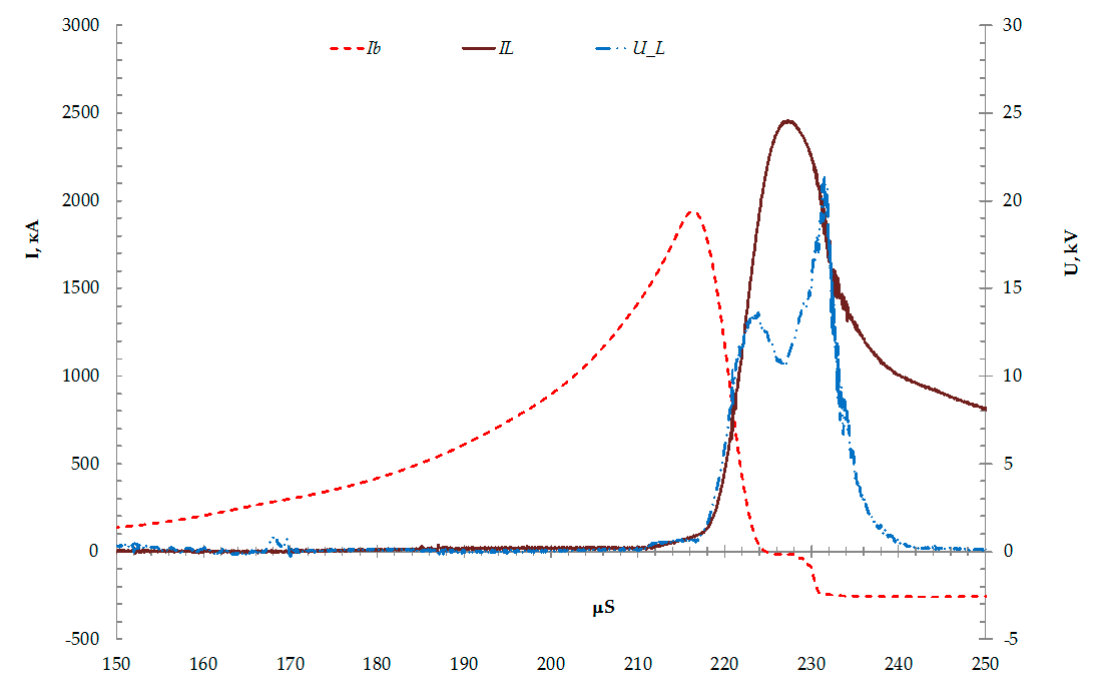
Figure 8. Current distributions in EMG, PPA, and voltage on PPA.